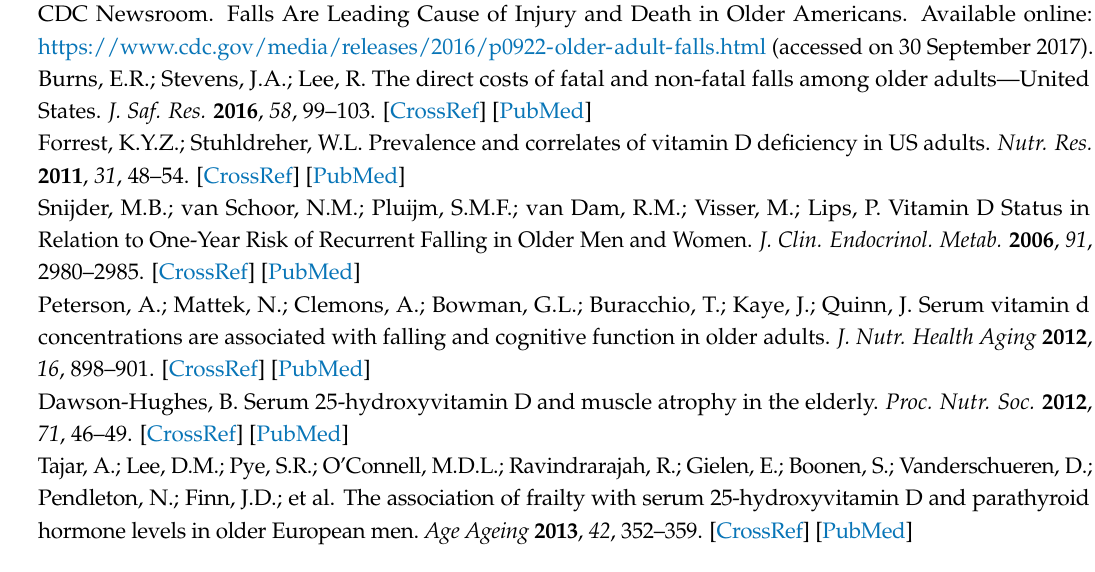
Table S1: List of included vitamin D and Falls Trials, Table S2: Trial recruitment and methodology characteristics, Table S3: vitamin D assessment at baseline and follow-up, Table S4: Trial intervention and follow-up characteristics, Table S5: Outcome assessment and reporting